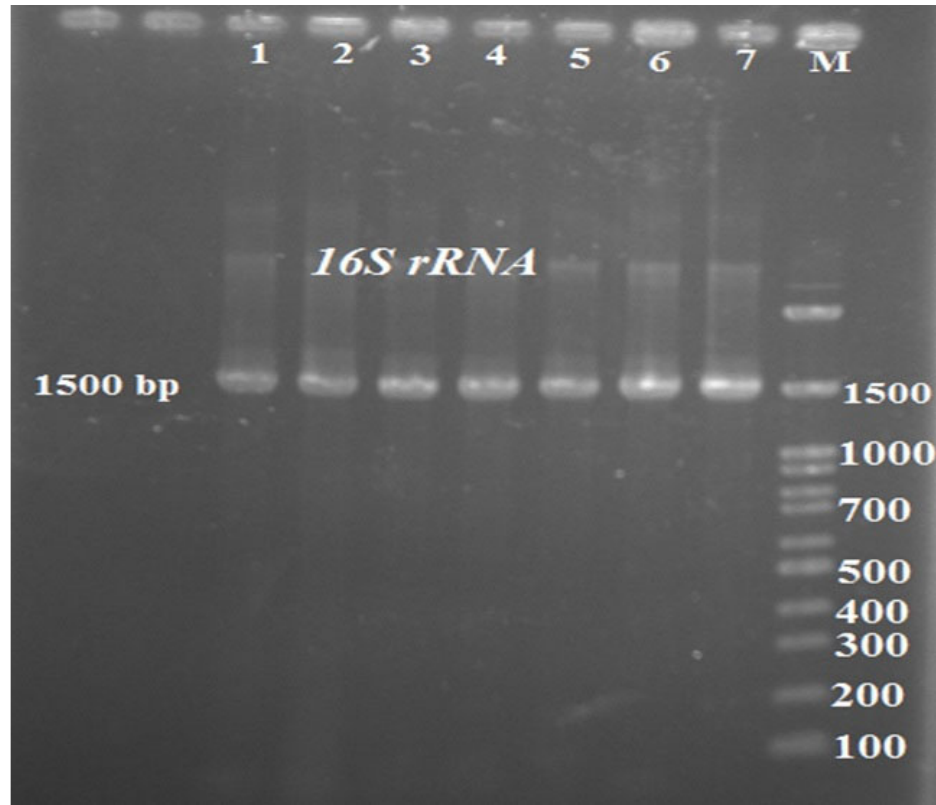
Figure 2. 16S rRNA PCR products. (1–7: samples 1 to 7; M: marker 100 bp) Table 2. Antibiogram result of M. morganii isolates from Hirudo medicinalis samples. Antibiotic